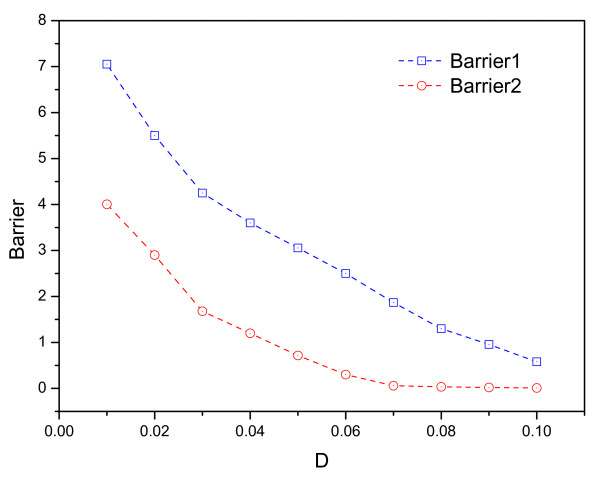
Barrier. The barrier height Barrier1 = Ufix - Umin and Barrier2 = Ufix - Umax versus diffusion coefficient D.